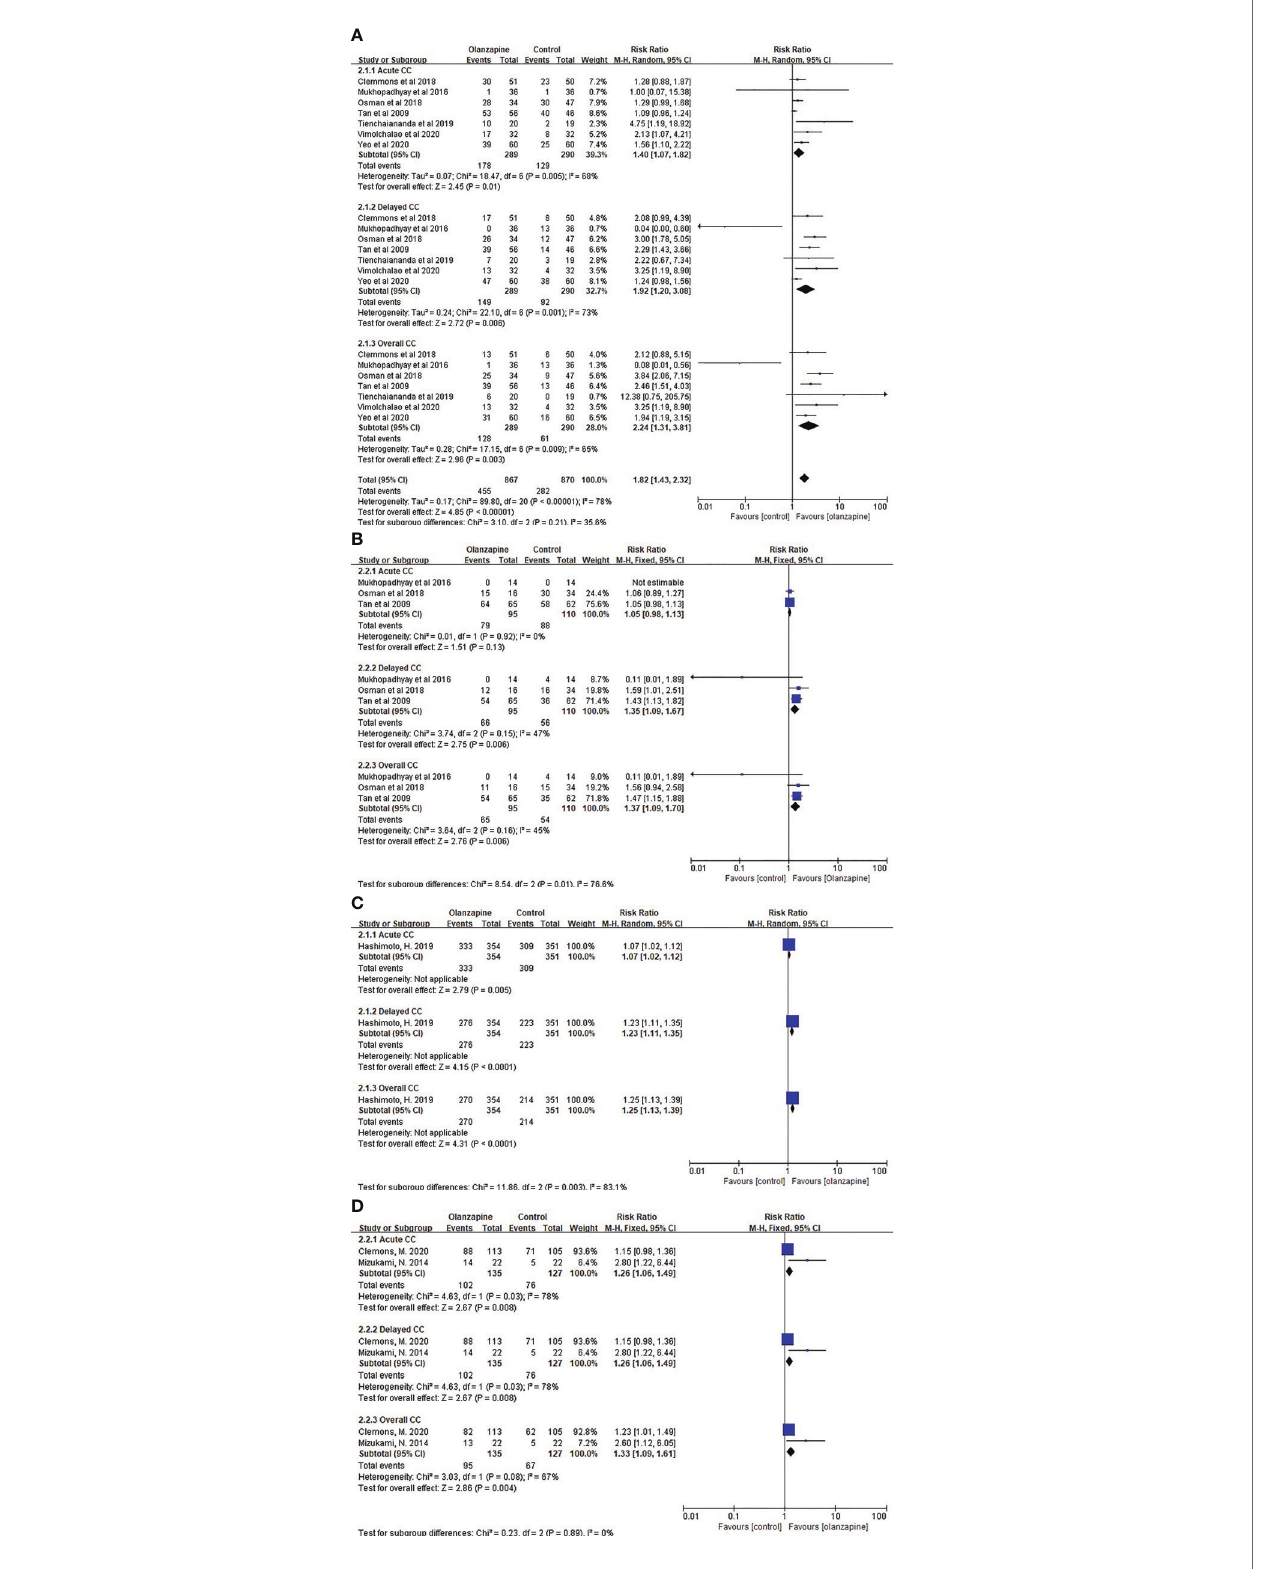
FIGURE 2 | Complete control (CC). (A) CC of 10mg Olz for HEC. (B) CC of 10mg Olz for MEC. (C) CC of 5mg Olz for MEC. (D) CC of 5mg Olz for